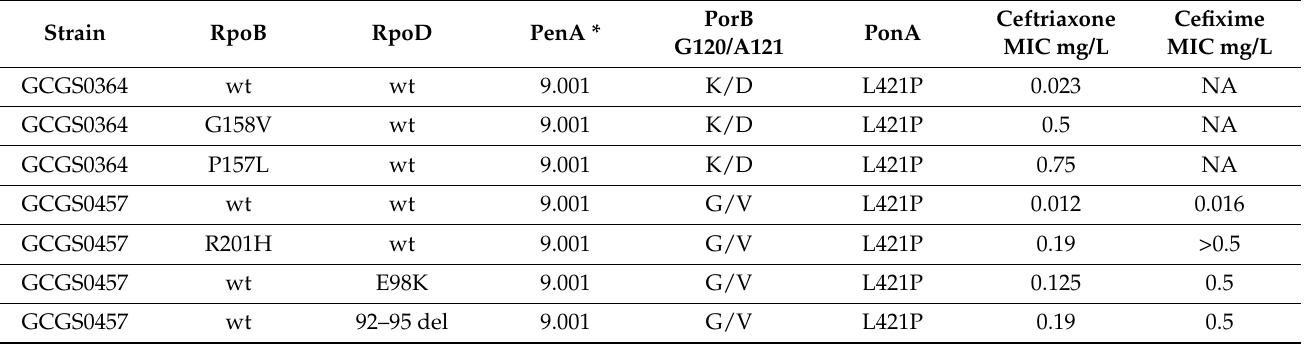
Strain RpoB RpoD PenA *